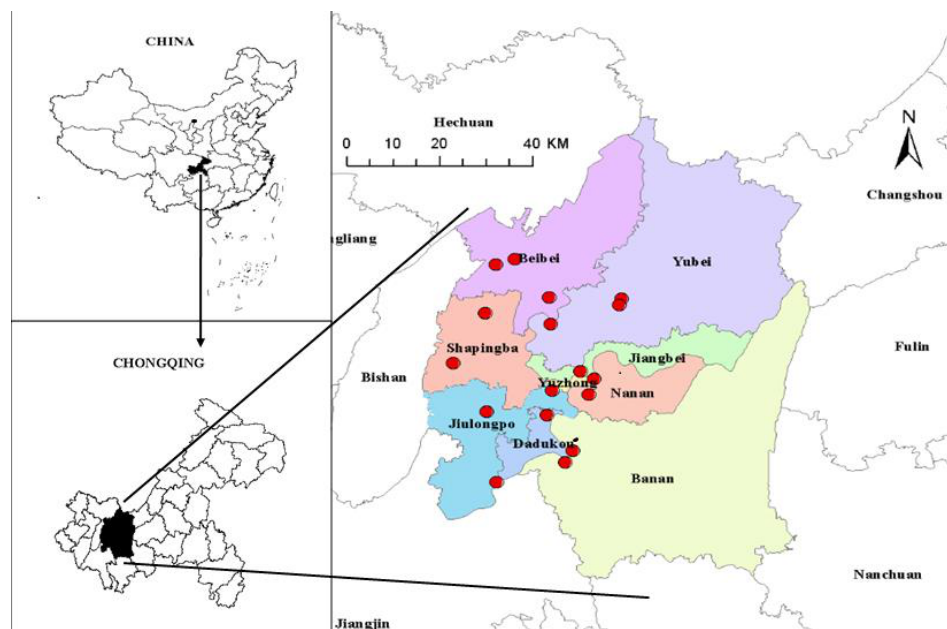
Figure 1. Locations for 17 monitoring sites (denoted by red circle) used to construct exposure estimates in Chongqing, China.